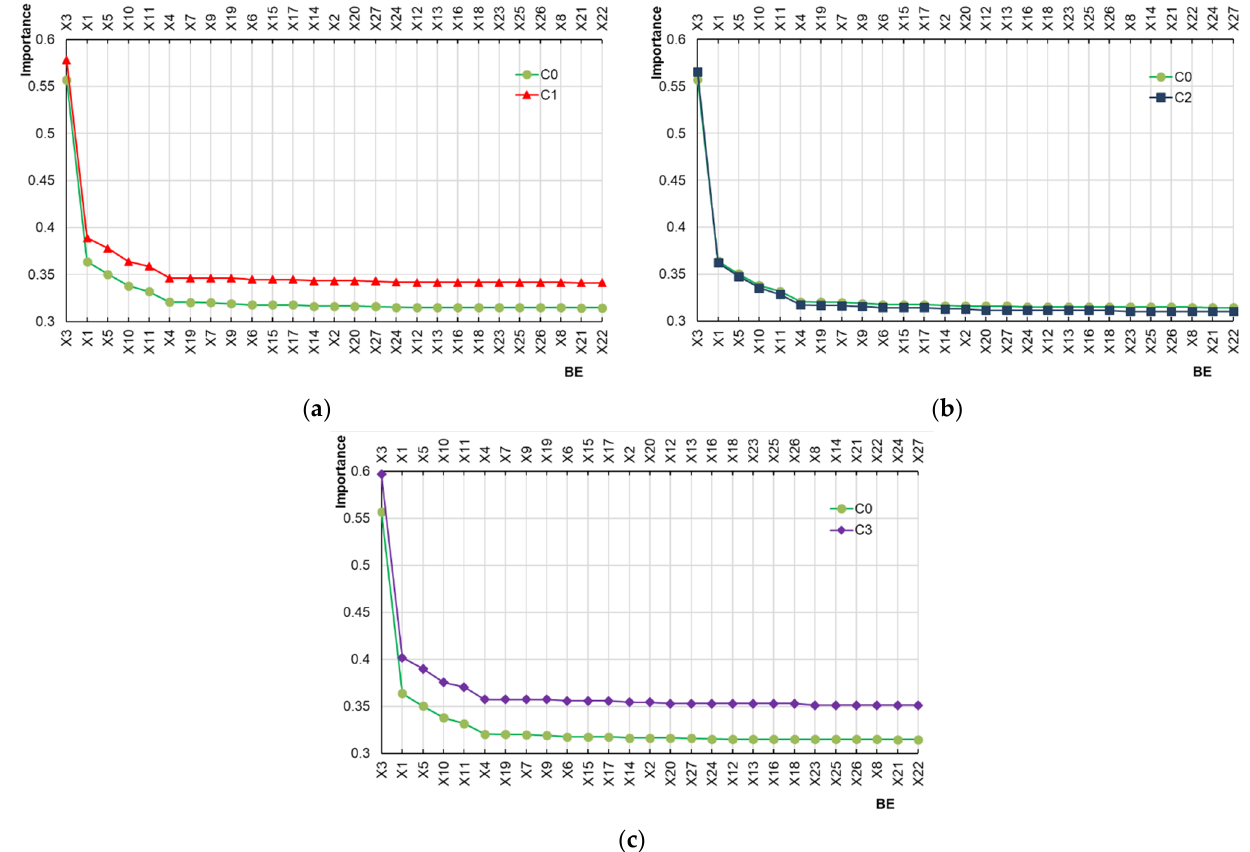
Figure 11. Comparison results of importance analysis in different cases: ( a ) Comparison between C 0 and C 1 ; ( b ) Comparison between C 0 and C 2 ; ( c ) Comparison between C 0 and C 3 .